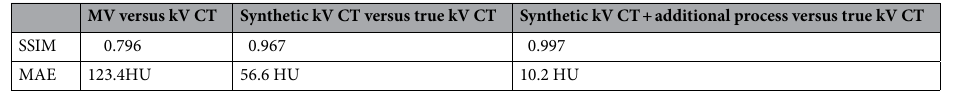
Table 1. Numerical analysis about image similarity between kV CT and synthetic kV CT, and the effect from additional processing to image